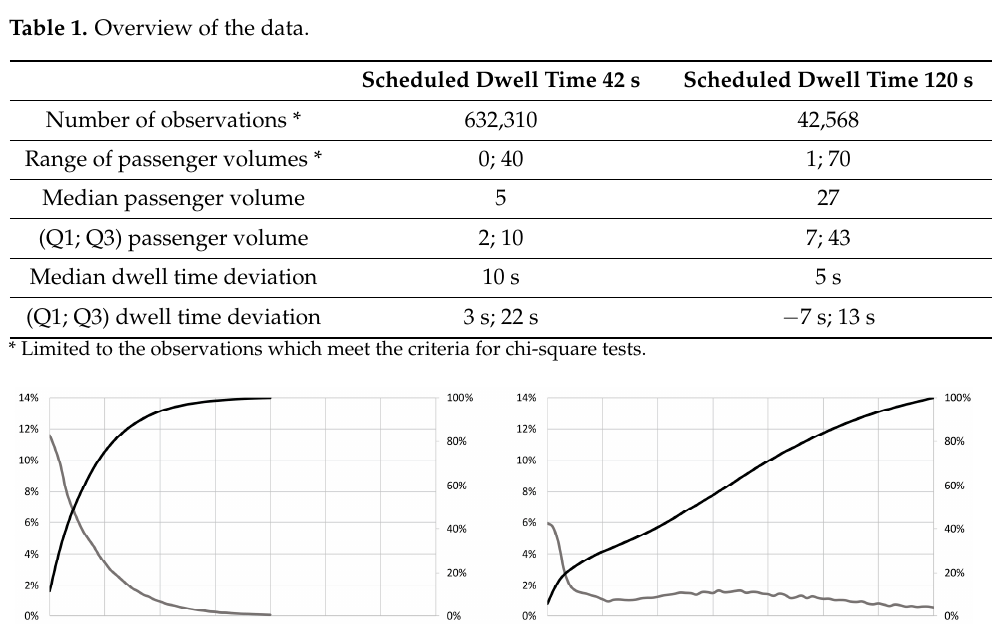
Table 2. Chi-square goodness of fit test results. Significant results indicated with an *, significance level p < 0.05.